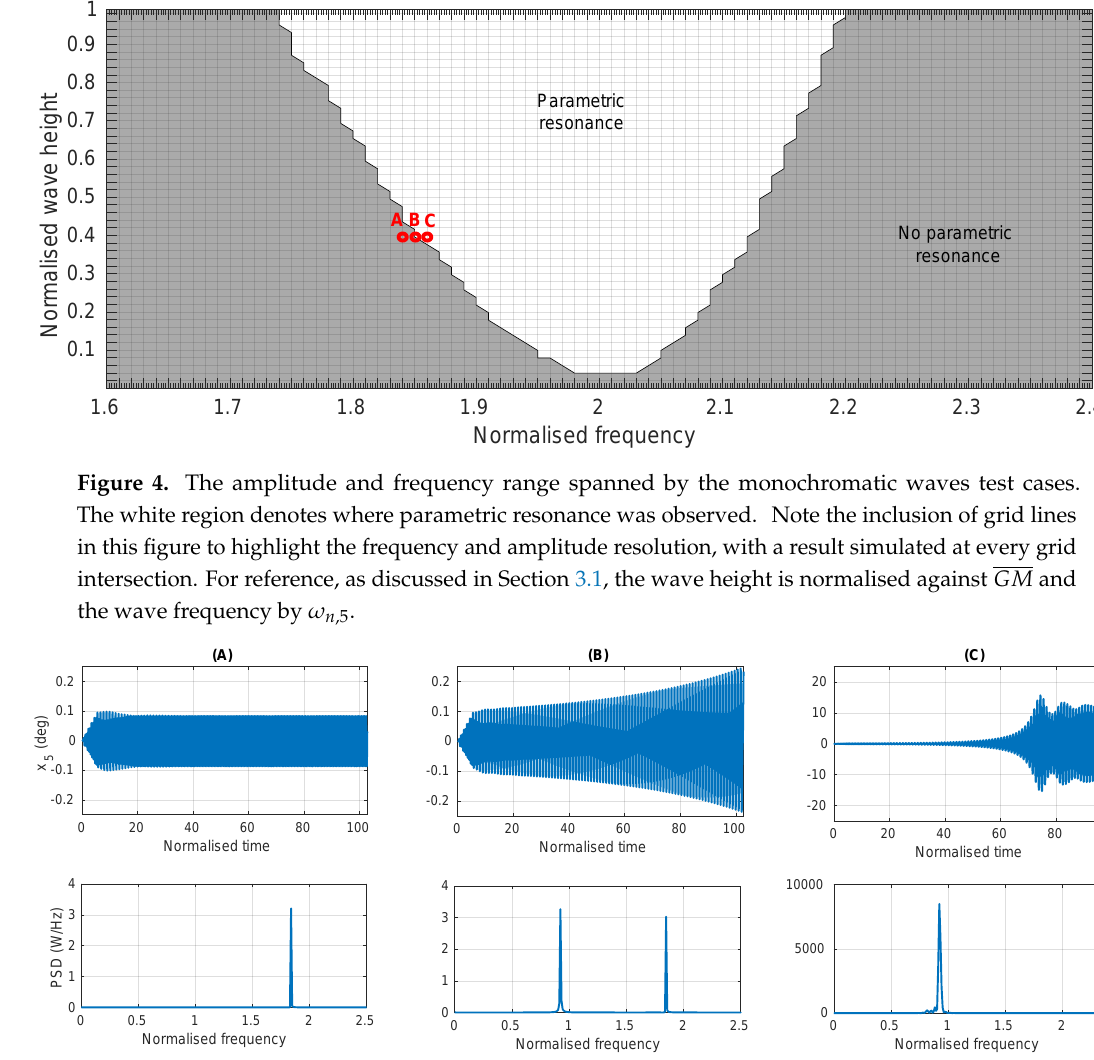
Figure 5. The pitch displacement time series and resulting PSD for the points (A) A, (B) B and (C) C in Figure